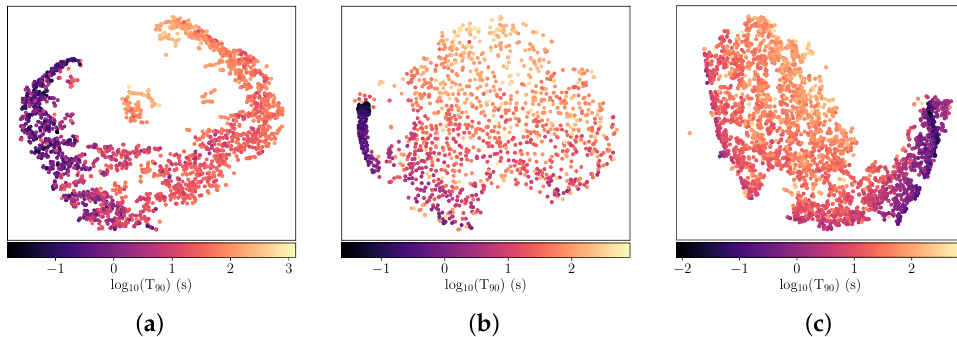
Figure 3. 2D t-SNE representation of the extracted wavelet and PCA features from the 64ms light curves from T 0 to T 100 , coloured by burst duration T 90 , for ( a ) BATSE, ( b ) Swift /BAT and ( c ) Fermi /GBM.